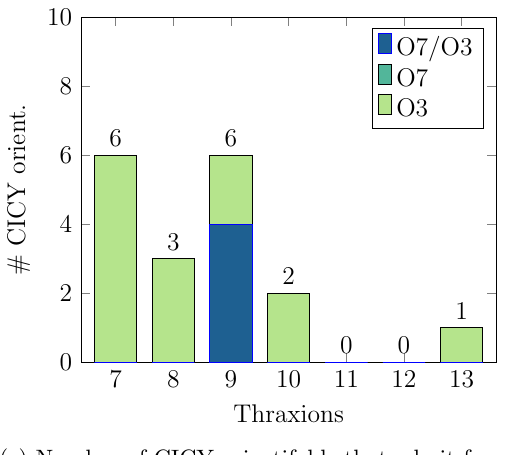
Figure 5 . Number of CICY orientifolds in M 1 for given number of thraxions. The different colors show the presence of both O7/O3-planes, or only O7 or O3-planes. The detailed numbers of